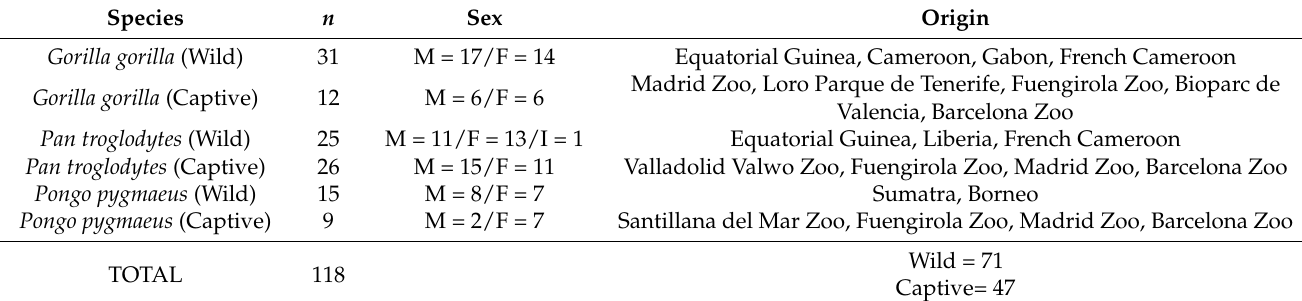
Wild = 71 Captive=